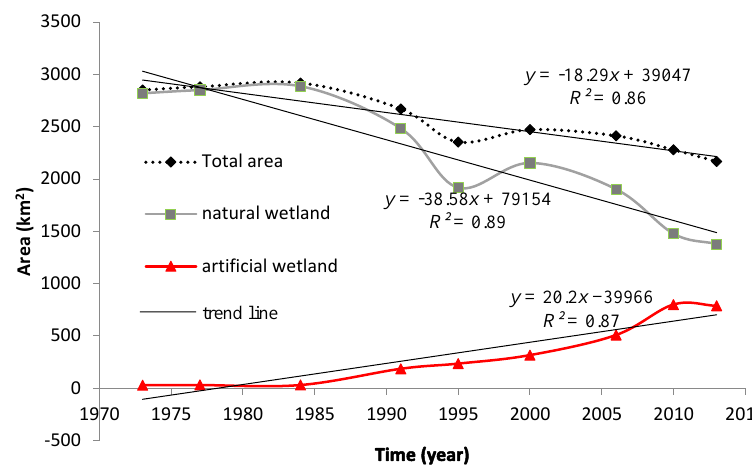
Figure 6. Area of natural and artificial wetlands in theYellow River Delta from 1973 – 2013.